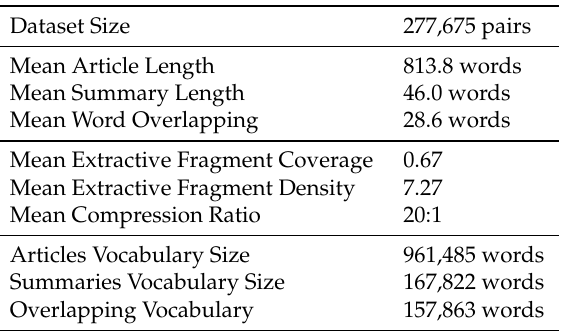
Table 1. ES-NEWS corpus